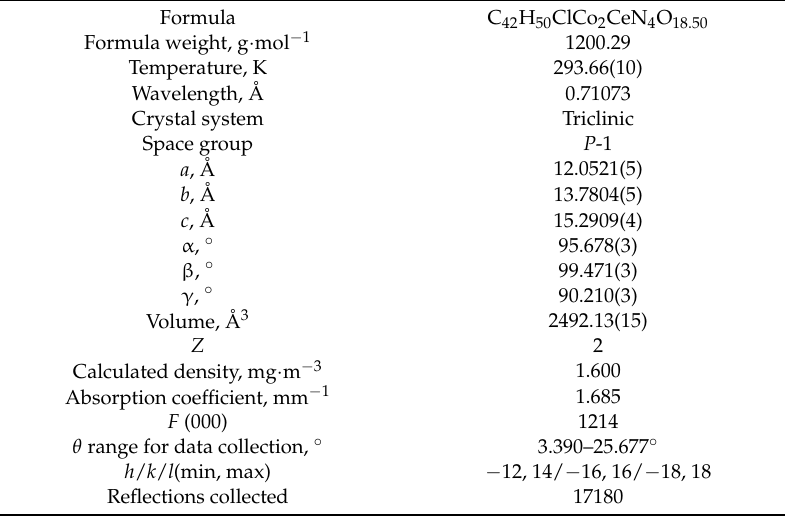
Table 2. Crystallographic data and structural refinement paramenters for the Co(II)-Ce(III) complex.